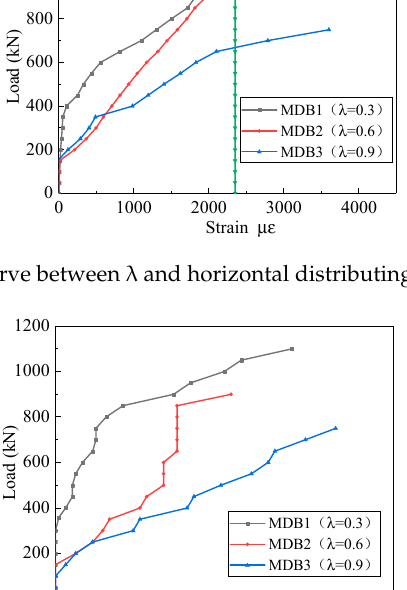
Figure 11. Relation curve between λ and maximum crack width.